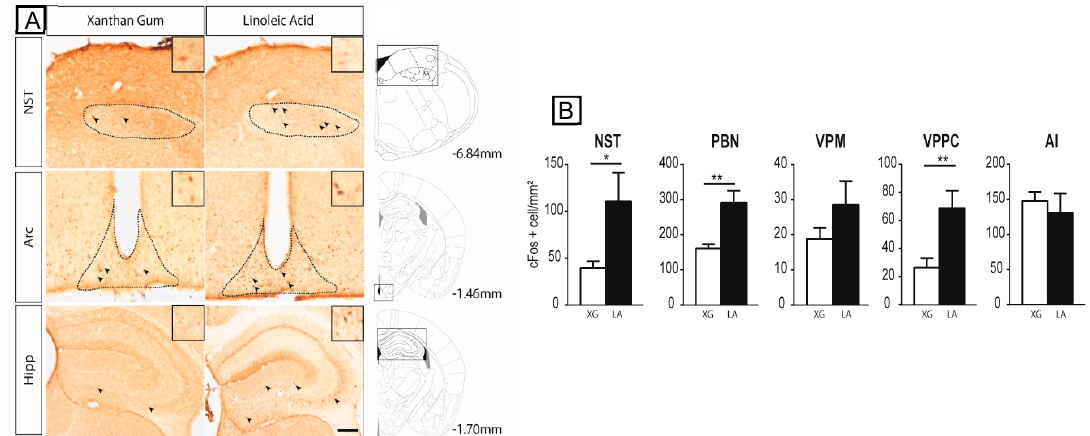
Figure 1. Linoleic acid deposition on the tongue induces c-Fos expression in the major cerebral structures of the canonical gustatory pathway. ( A ) Typical photomicrographs of the NST, Arc, and Hipp, showing c-Fos immunoreactivity in mice subjected to oral stimulation with linoleic acid or xanthan gum (XG, 0.3%, w / v ) to mimic the texture of lipids. The dotted lines circumscribe the regions of interest. Arrowheads point to representative c-Fos immunopositive nuclei. The boxes show higher magnification (×4) of representative c-Fos immunopositive nuclei. Scale bar, 100 µm. The square windows indicate the area shown in the photomicrographs. ( B ) Bar graph representation of the density of c-Fos immunopositive cells (number of c-Fos positive cells/mm 2 ) in mice subjected to oral stimulation with linoleic acid (LA) or xanthan gum (XG). Values are means ± standard error of the mean (SEM); n = 6; for each structure studied, treatment effects on c-Fos expression were assessed